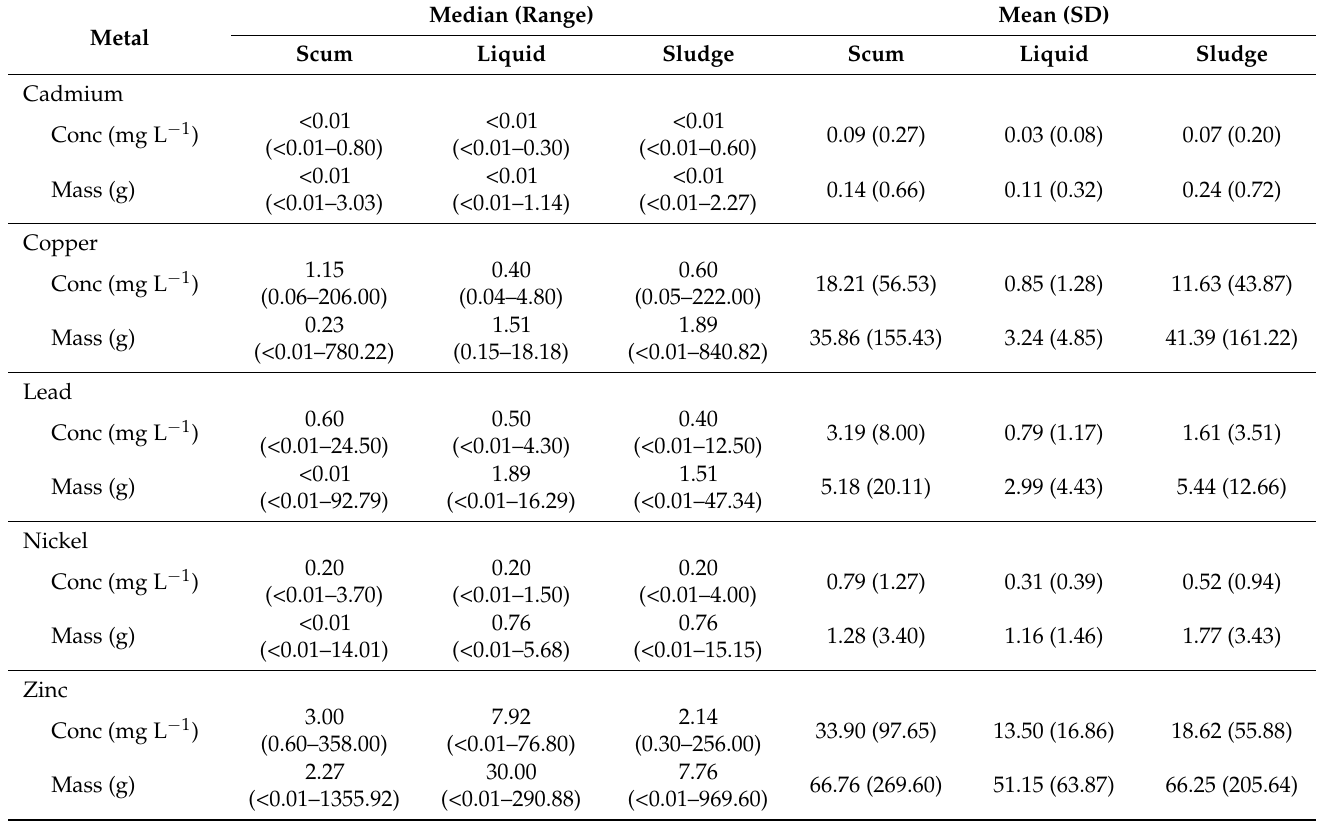
Table 2. Median (range) and mean (standard deviation (SD)) of trace metal concentration (Conc) and mass in each septage